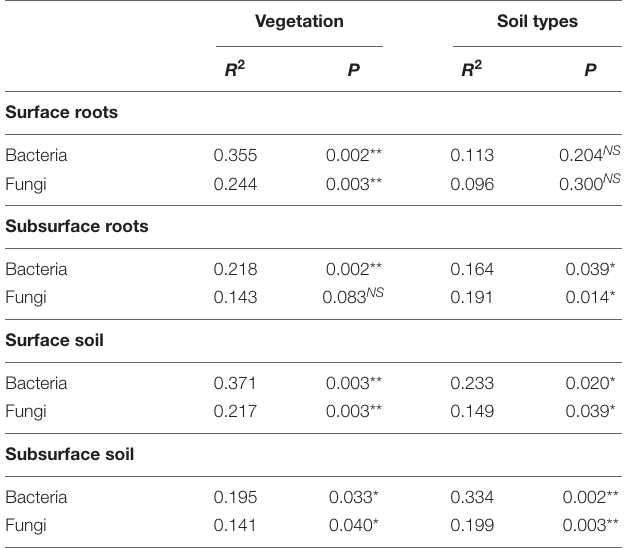
TABLE 2 | Effects of vegetations (Acacia and Native) and soil types (Oxisols and Ultisols) on bacterial and fungal community structures in surface and subsurface roots and soils.